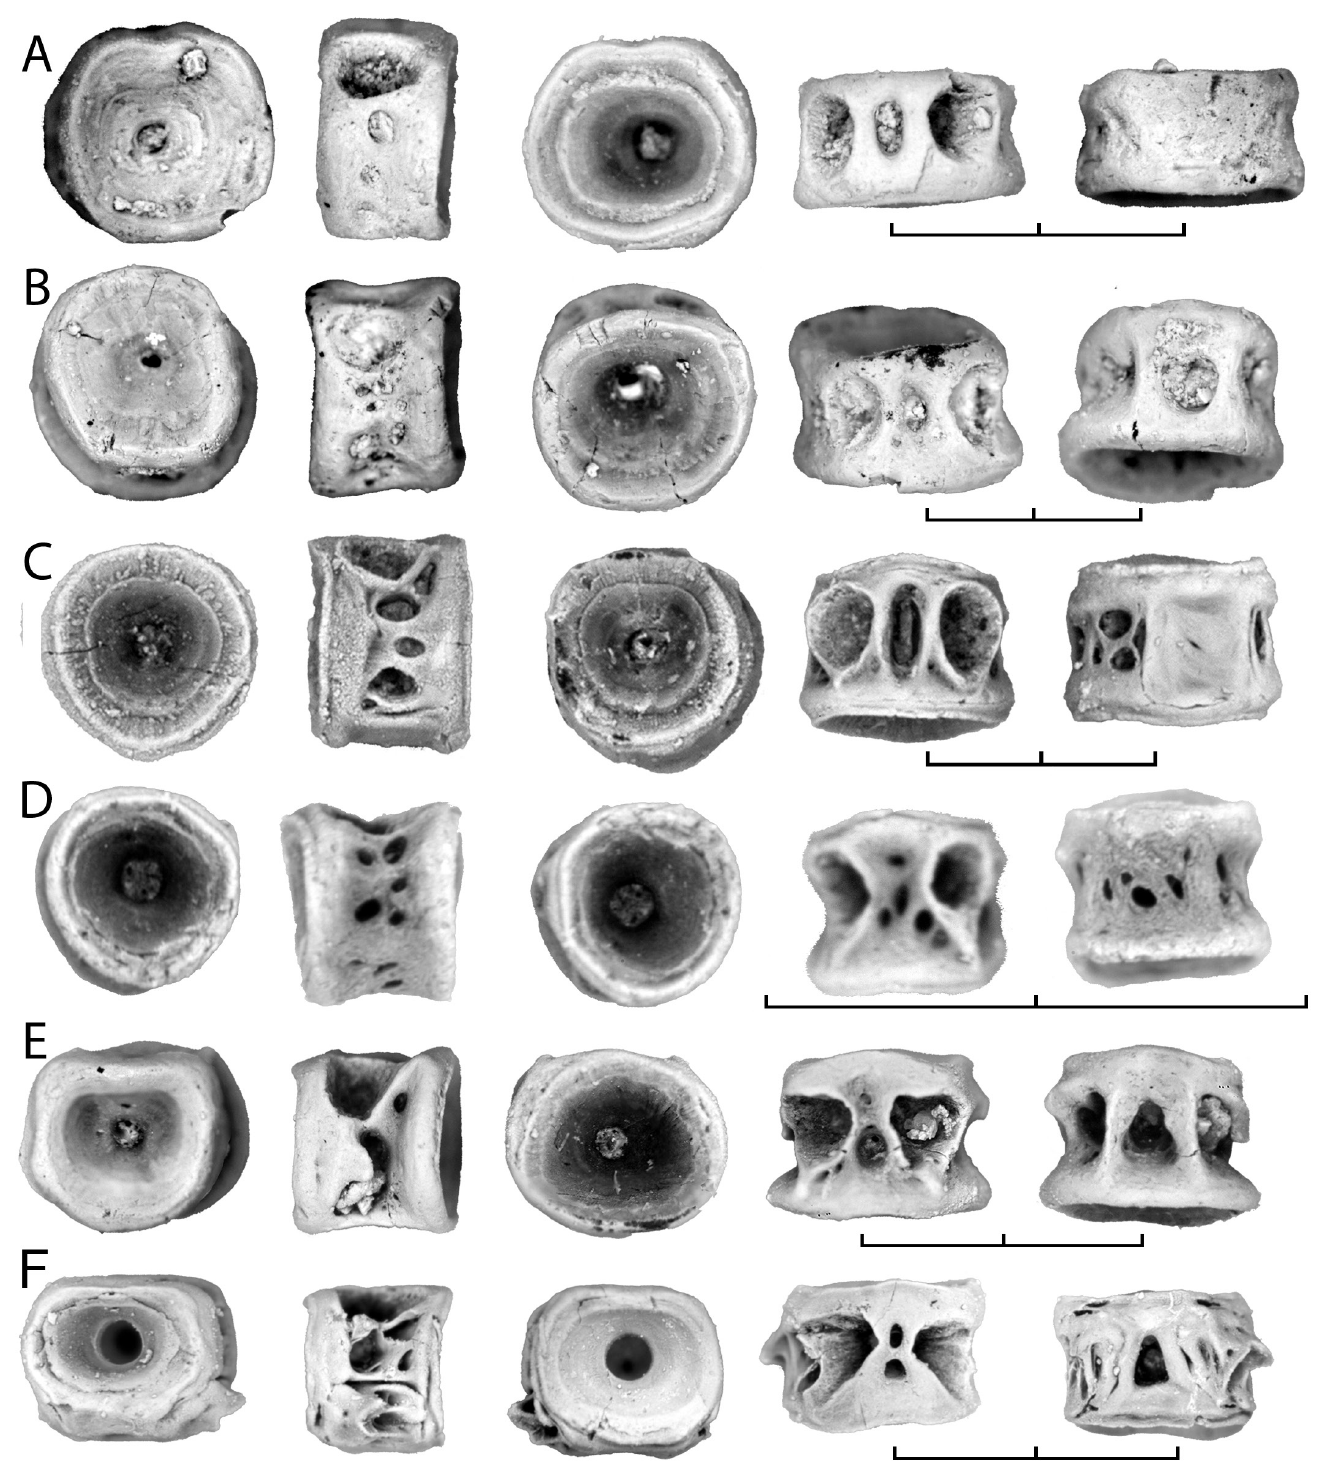
Figure 22. Centra of Telostei indet. type U-4 from the Milk River Formation compared with specimens from the Santonian of Utah, Campanian of Alberta, and Paleocene of Montana. A – C) Centra of Telostei indet. type U-4 from the Milk River Formation, showing variation in the development of a mid-ventral pit and in the length of the centrum: A, UALVP 48869; B, UALVP 48870; C, TMP 2000.001.0069. D) centrum of Telostei indet. type U-4 from the Santonian John Henry Member of the Straight Cliffs Formation, UMNH VP 19136. E) centra of Telostei indet. type U-4 from the Belly River Group, TMP 2015.060.0026. F) centrum from the early Paleocene Tullock Formation of Montana, specimen UCMP 230709/V2210. Centra shown in anterior, left lateral, posterior, dorsal and ventral views. D from Brinkman et al. (2013: fig. 10.23B). Scale bar equals 2